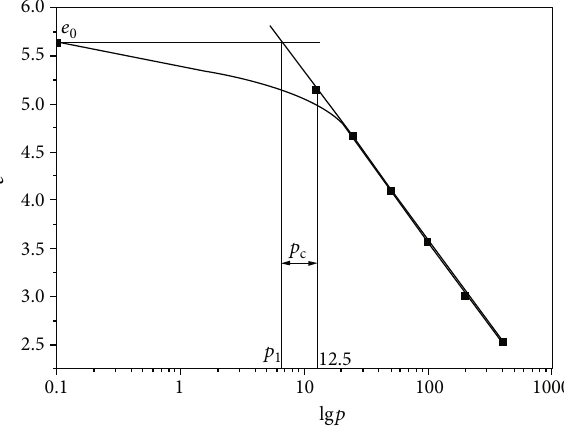
Figure 9: The e ‐ lg p curve and compression index C